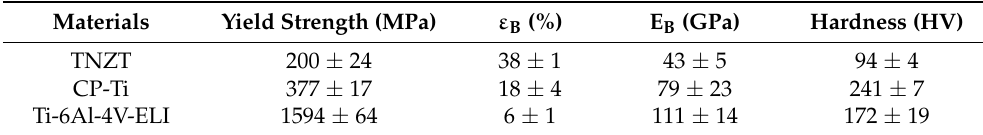
Table 2. Mechanical parameters obtained from the flexural strength tests and